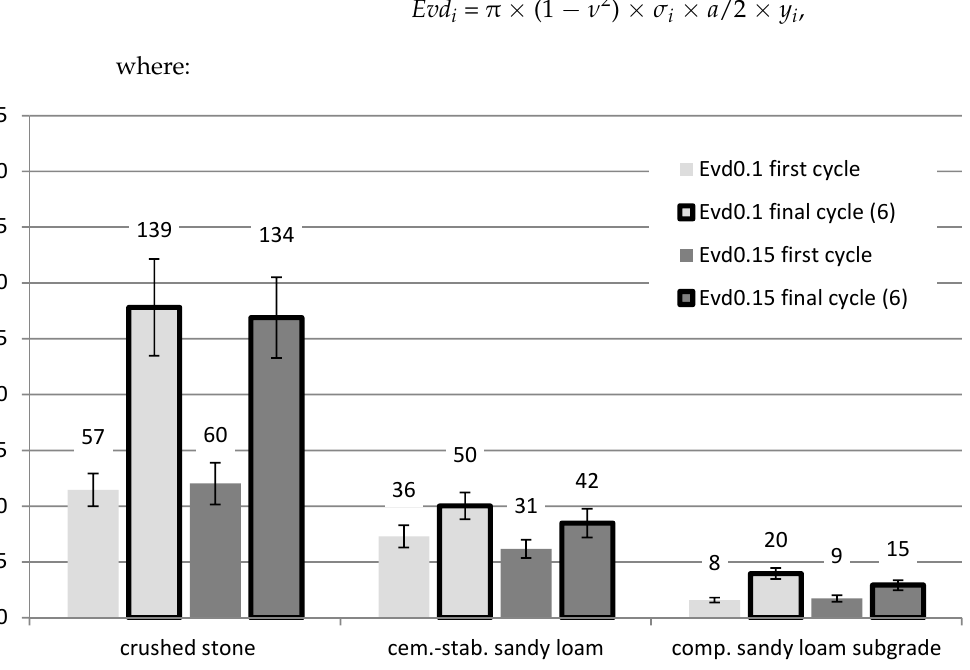
Figure 6. Values of dynamic moduli of the tested structures.